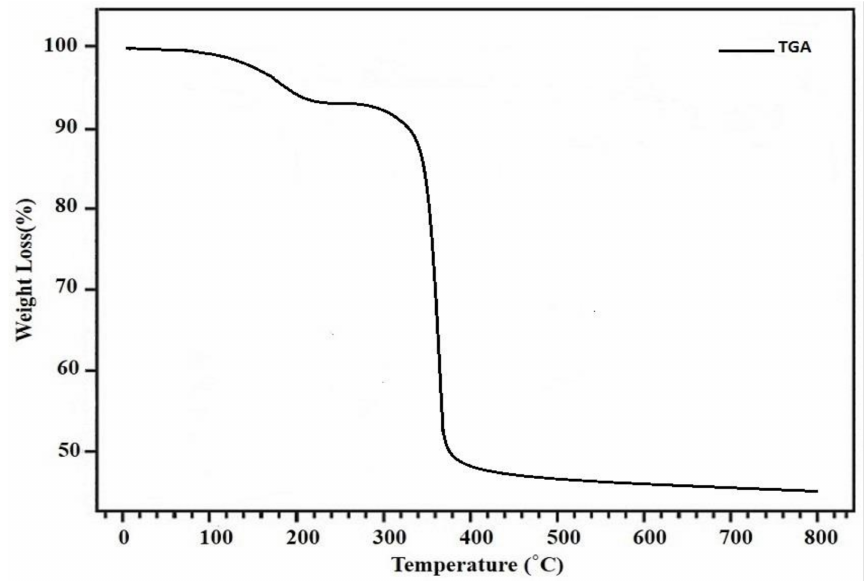
1 with a mass loss of about 45.3% . The remained solid around 800 ◦ C is probably CdO (Figure 11).